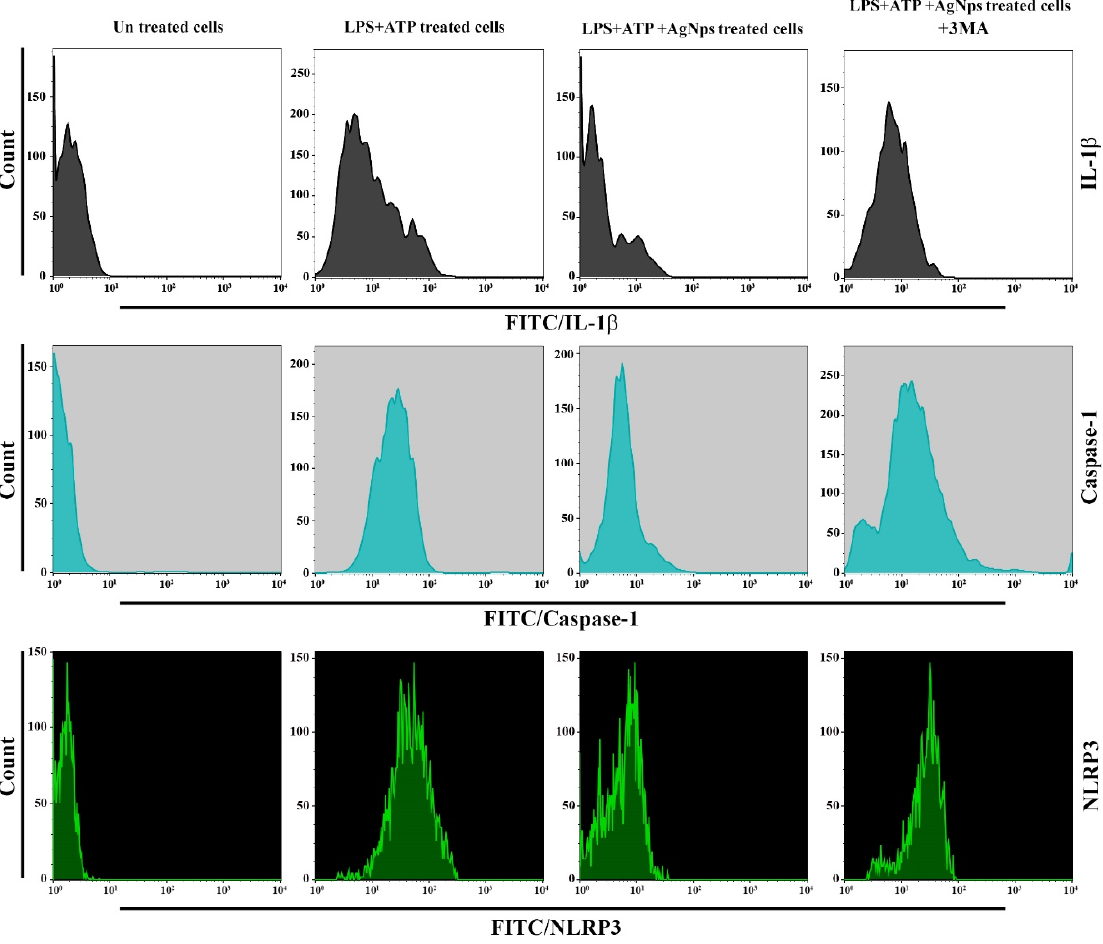
Figure 13. Inhibition of autophagy blocks the role of AgNPs in inflammasome activation. Cells were left untreated as a control or treated with LPS+ATP, with and without treatment with 5 μ gmL − 1 AgNPs, with 3-MA at concentration 10 mM. Flow cytometry analysis was performed for the indicated proteins.